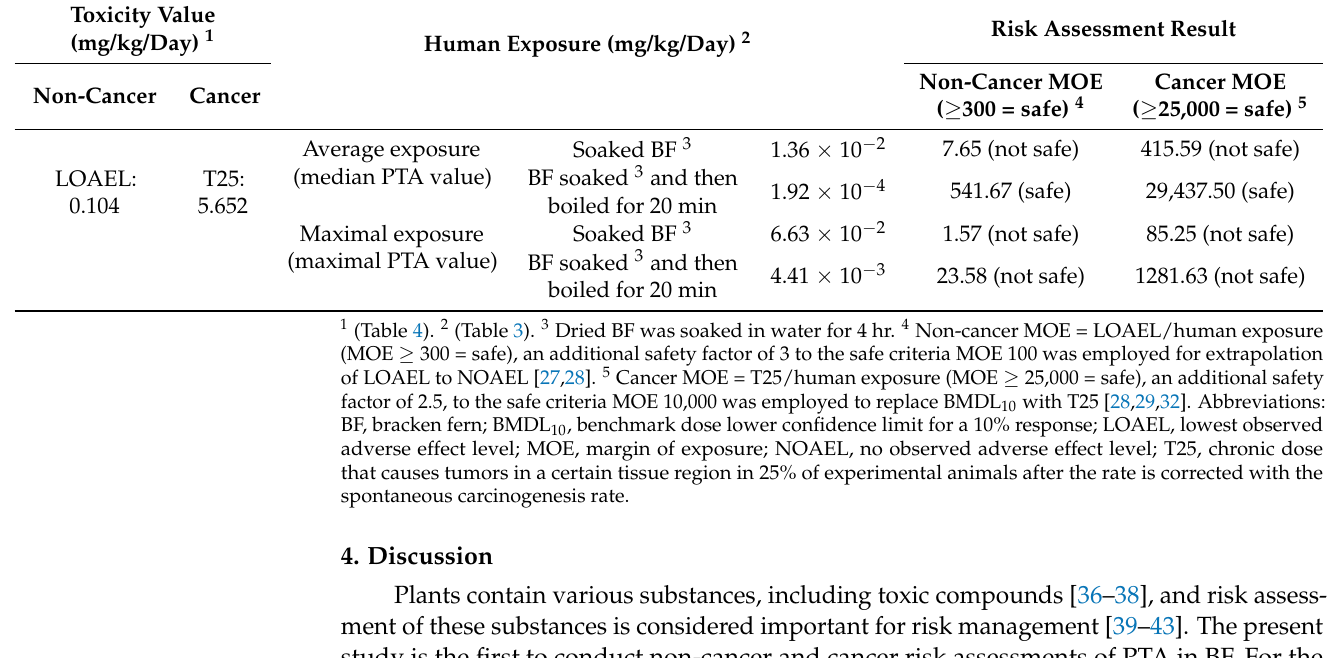
Table 5. Non-cancer and cancer risk assessment results for